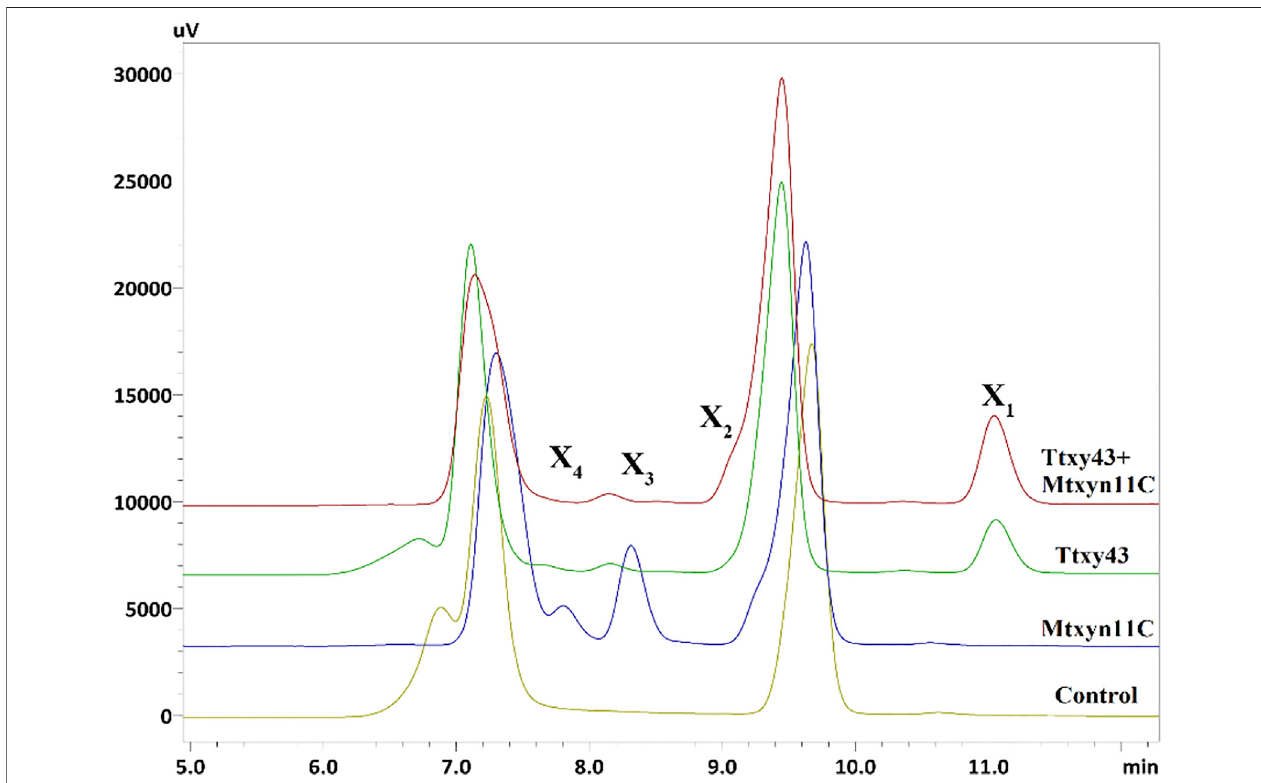
FIGURE 6 | HPLC pro fi le of hydrolyzed products of BWX, showing hydrolytic ef fi ciency of Mtxyn11C and Ttxy43 for conversion of BWX. Control: BWX without added enzyme. (X 1 , xylose; X 2 , xylobiose; X 3 , xylotriose; X 4 ,